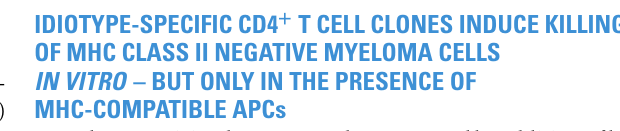
FIGURE 1 | Direct and indirect killing of tumor cells by CD4 + T cells. (A) CD8 + T cells can directly kill tumor cells that express MHC class I molecules, whereas (B) cytotoxic CD4 + T cells can kill tumor cells that express MHC class II molecules. (C) While most tumor types express MHC class I molecules, they often lack expression of MHC class II. How do CD4 + T cells recognize and eliminate MHCII NEG tumor cells? (D) CD4 + T cells may kill